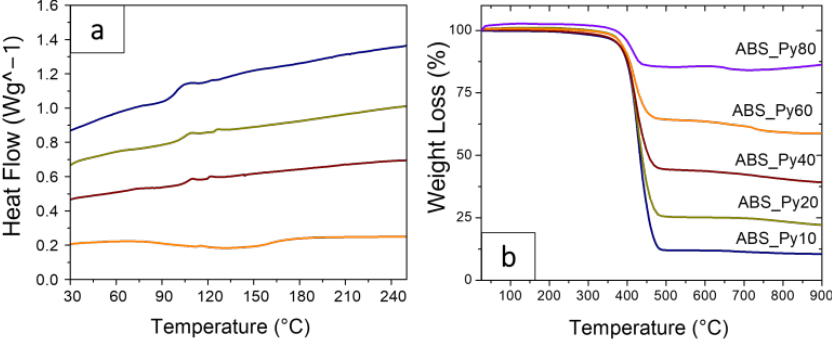
Figure 5. ( a ) Differential scanning calorimetry (DSC) curves for the neat polymer and representative composites. ( b ) TGA curves of the different ABS – Py composite samples.